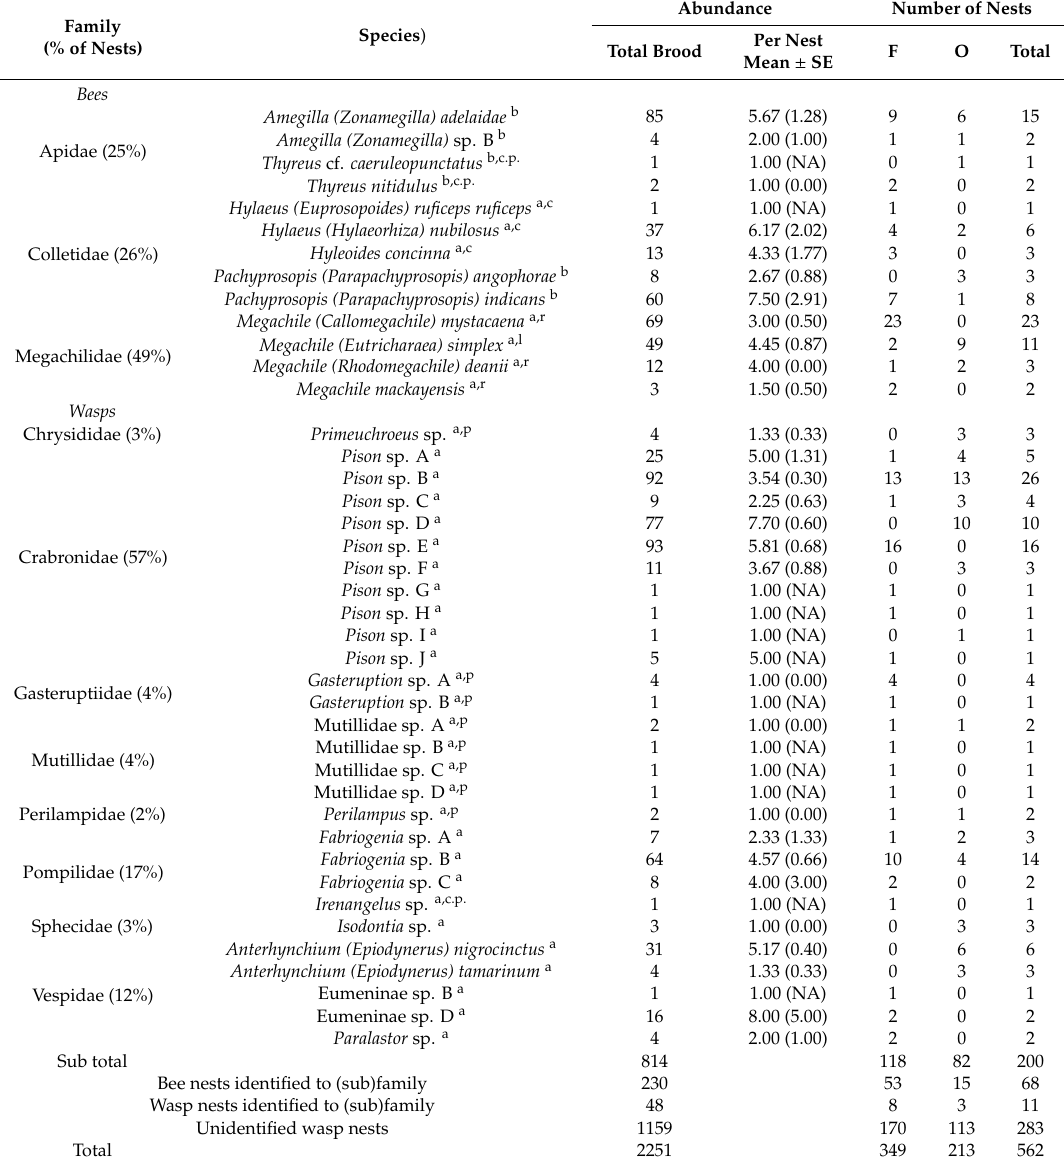
Table 2. Taxa identified in trap nests and their abundance in forests (“F”) and orchards (“O”). Some trap-nesting bees and wasps were found only in forests or orchards. Symbology shows aboveground nesting a , belowground nesting b , cleptoparasitic c.p. , parasitic p , cellophane c , leafcutter l and resin-collecting r species. Abundance indicates total and mean ( +/ − se) number of adult emergents for ground-nesting bees and of brood cells for cavity-nesting bees and wasps. All specimens are determined to species and labelled by taxa names or letters “A” to “J” after “sp.” for unnamed taxa. Abundance Number of Nests Family Species ) Per Nest (% of Nests) F O Total Brood Mean ± SE